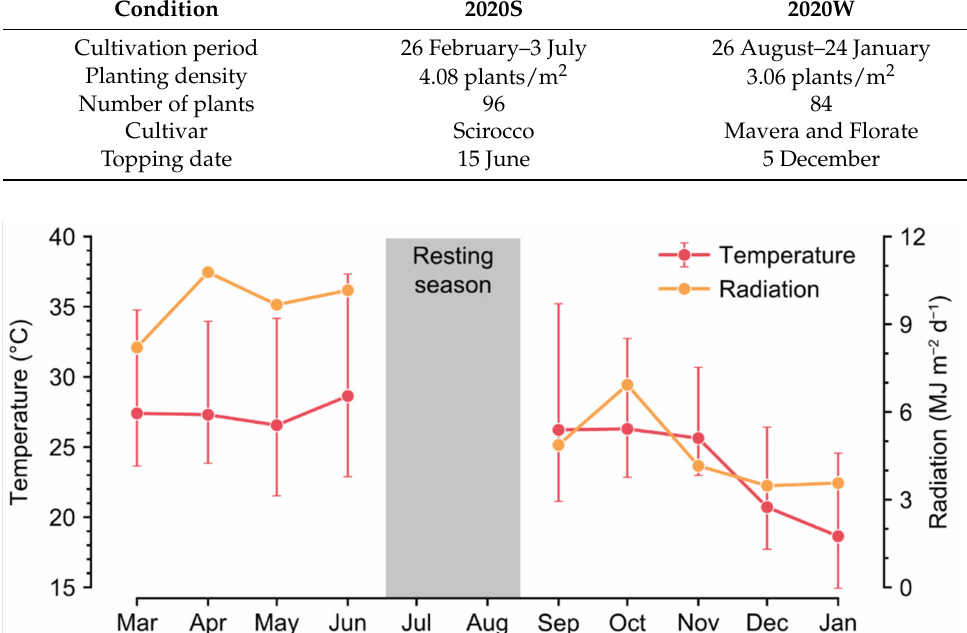
Figure 1. Daily temperature and radiation in the greenhouse. Minimum and maximum values for temperature are shown. No cultivation was conducted in the resting season. The crops